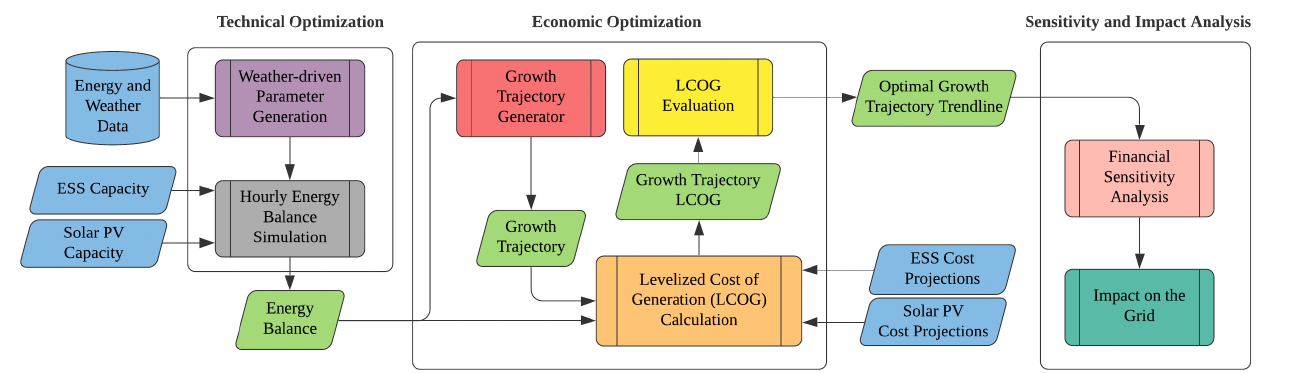
Figure 4. Proposed Cost-Optimal Storage Capacity Assessment using Hourly Simulation, Monte Carlo Sampling, and Levelized Cost of Generation. Blue parallelograms represent the input of the system such as the ESS and PV capacity for the scenarios and the ESS and PV cost projections for the financial calculation. Green parallelograms represent the intermediate output of the processes.